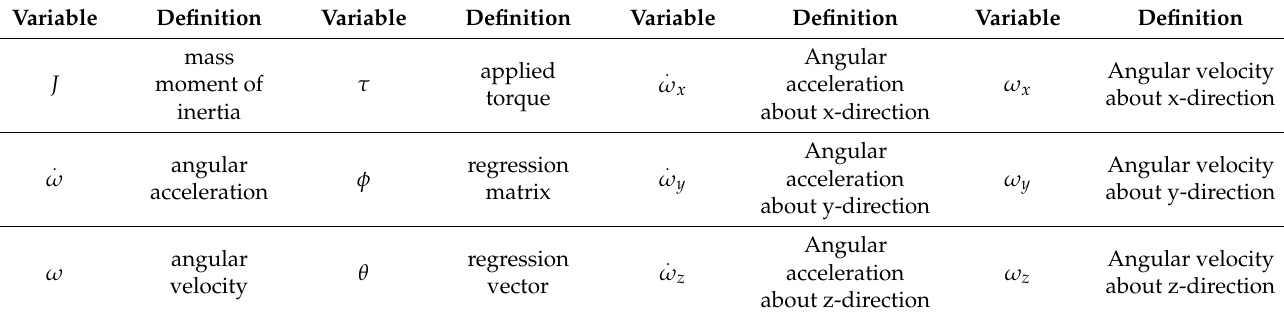
Table 1. Definitions of variables proximal to Table 1.